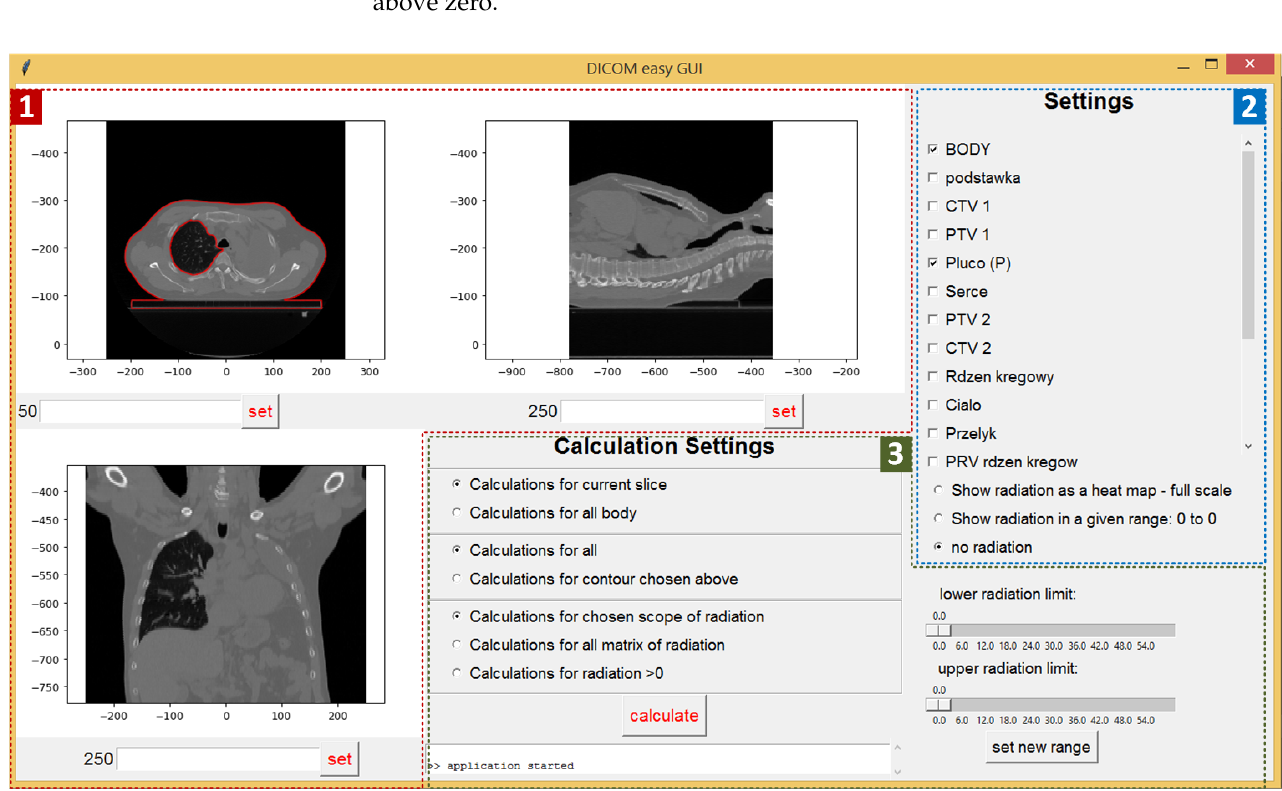
Figure 21. The main window of the